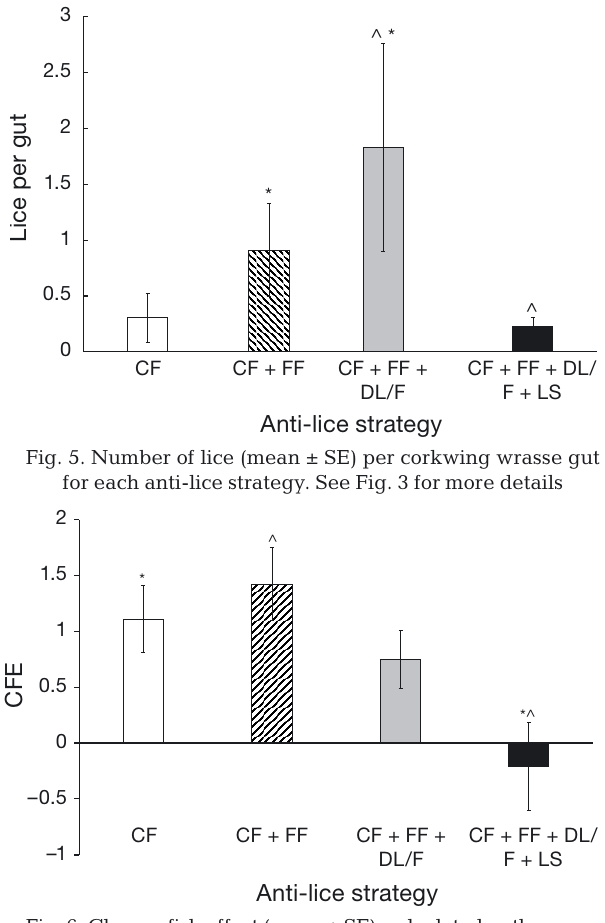
Fig. 6. Cleaner fish effect (mean ± SE), calculated as the mean Fig. 4. Mean (± SE) number of (a) attached and (b) mobile lice predicted number of lice minus the mean actual number of lice per salmon in each treatment at Samples 1 and 2. See for each anti-lice strategy. See Fig. 3 for more Fig. 3 for more details